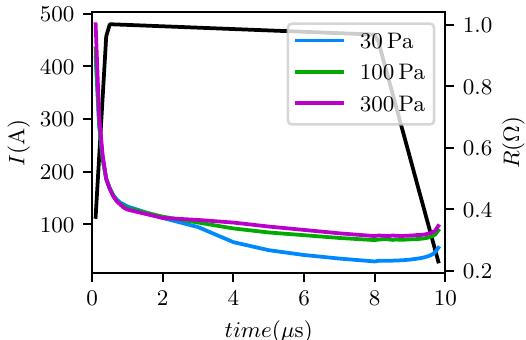
Figure 7. Approximation of the measured electric current ( I ) and time dependencies of tube resistance for initial pressures of the filling gas: 30Pa, 100Pa, and